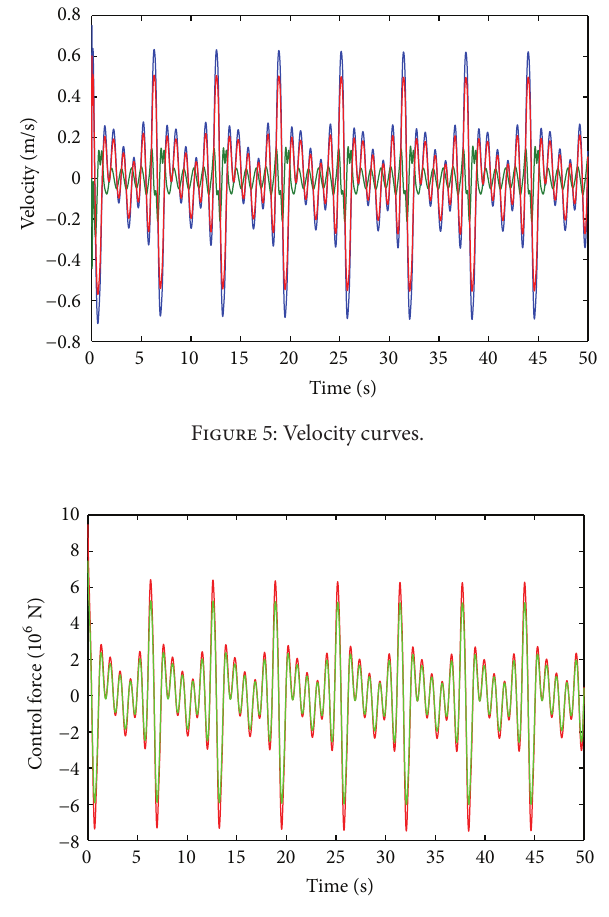
Figure 6: Control force